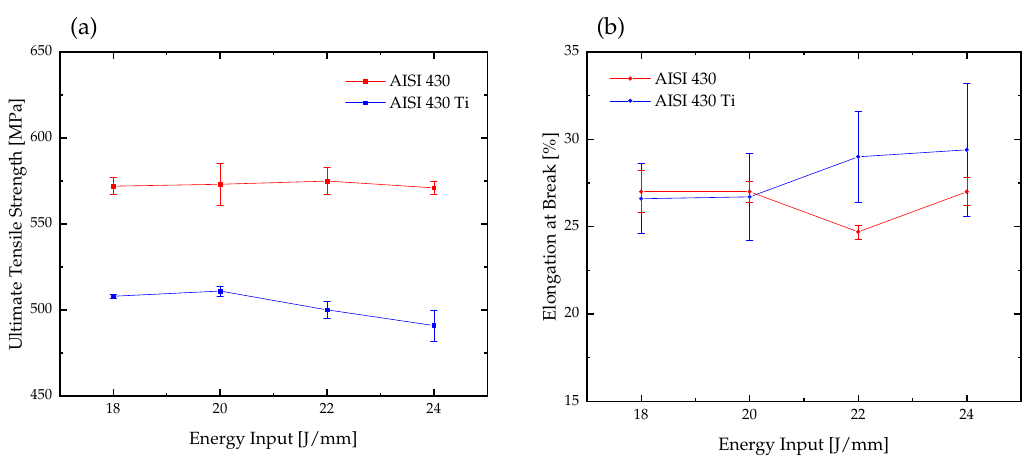
Figure 10. Comparison of ( a ) ultimate tensile strength and ( b ) elongation at break for both materials investigated, welded at different energy inputs. Mean values and SEM calculated from five tensile